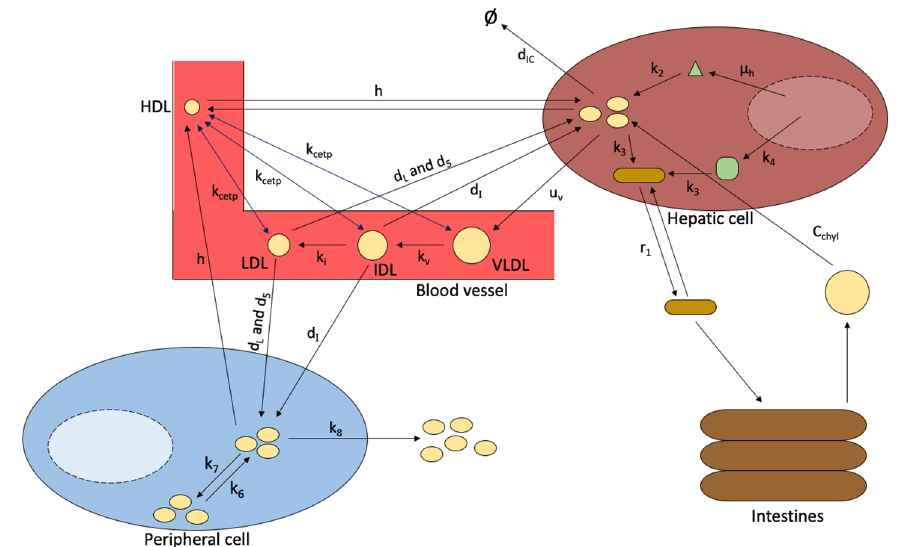
Figure 8. Cumulative figure of all important processes with parameters. In hepatic cell, intracellular cholesterol can be synthesized or taken from chylomicrons, HDL, IDL, or LDL. Intracellular cholesterol can leave in bile acids or VLDL or can be given to HDL. In peripheral cell, intracellular cholesterol can be synthesized or taken from LDL or IDL. Intracellular cholesterol in peripheral cells can also be lost to HDL. The blood stream system is involved in the cholesterol transportation. Intestine has important role in both cholesterol uptake and bile salt excretion.